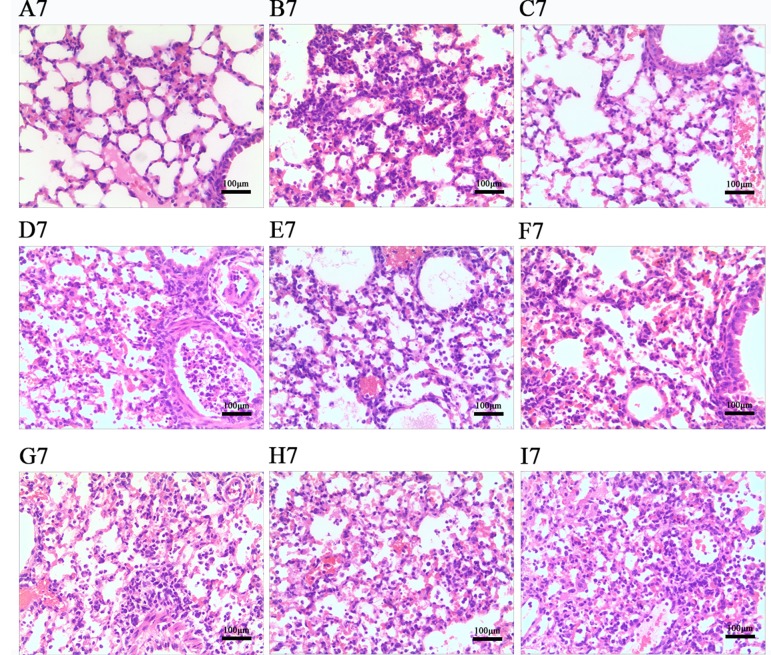
Photomicrographs of lung tissue morphology of mice at day 7 post-infection with HE staining (magnification, 100×). (A) The control uninfected group; (B) the control infected group; (C) oseltamivir group; (D) LEP 40 mg/kg group; (E) LEP 20 mg/kg group; (F) LEP 10 mg/kg group; (G) DPEP 40 mg/kg group; (H) DPEP 20 mg/kg group; (I) DPEP 10 mg/kg group. The number 7 means the 7th day after infection.